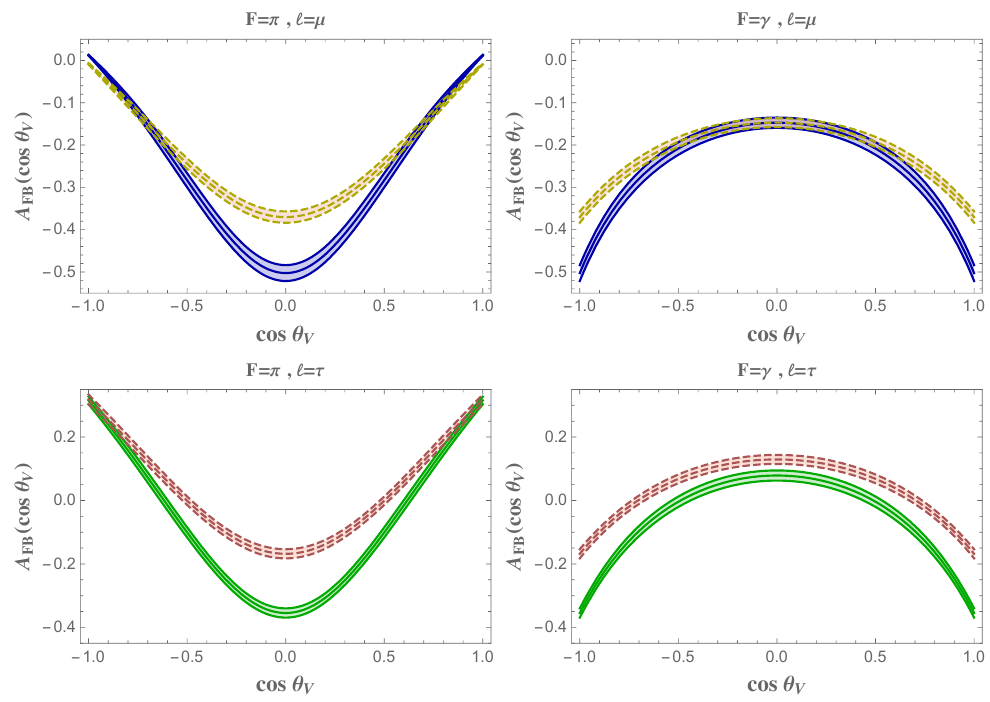
Figure 11 . cos (cid:18) V -dependent forward-backward asymmetry de(cid:12)ned in (6.8). The upper and lower plots refer to ‘ = (cid:22) and ‘ = (cid:28) , respectively, the left and right column to F = (cid:25) and F = (cid:13) . The solid curves correspond to SM, the dashed ones to NP at the benchmark point ~ (cid:15) ‘ (cid:0) cos (cid:18) , since the (cid:12)rst two terms are invariant under this transformation, while the